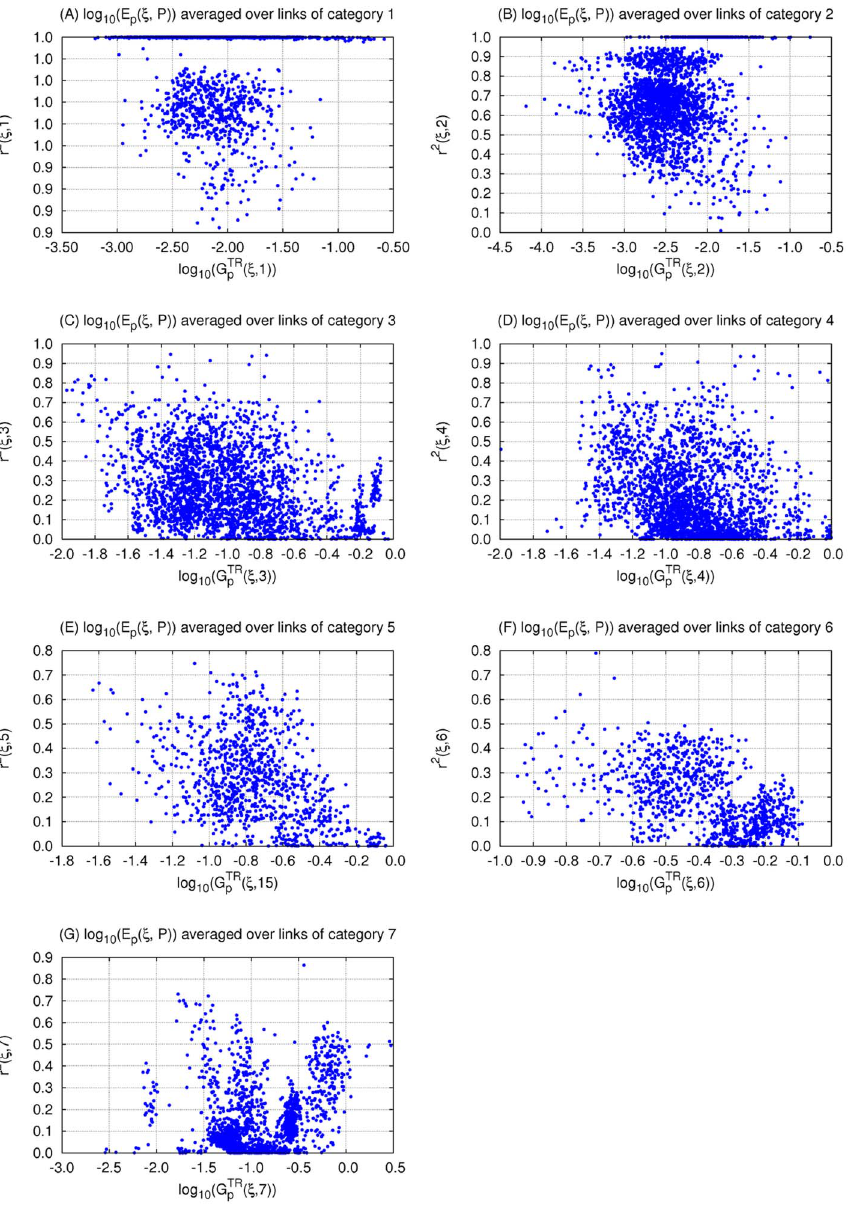
Figure 9. r 2 within the networks of each 3-node topology divided into 7 categories. Within each topology j , the overall robustness to parameters in category j ~ 1,2, (cid:2)(cid:2)(cid:2) 7 is shown versus r 2 j , j ð Þ , the r 2 of the correlation (i.e., square of the Pearson correlation) between log 10 E I j , ~ PP (cid:2) (cid:3)(cid:2) (cid:3) , for j =1 (A), 2 (B), 3 (C), 4 (D), 5 (E), 6 (F), and 7 and log 10 E p j , ~ PP , j